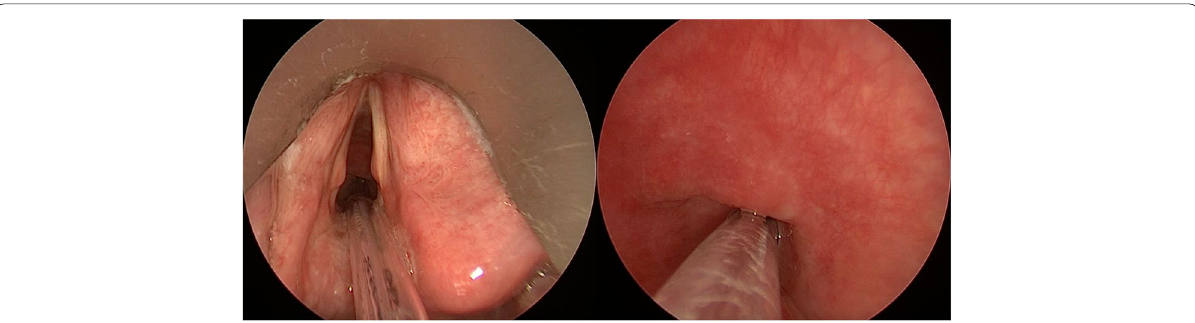
Fig. 4 Example of a patient with severe subglottic stenosis intubated with Tritube. Laryngoscopic view above (left) and under (right) the vocal